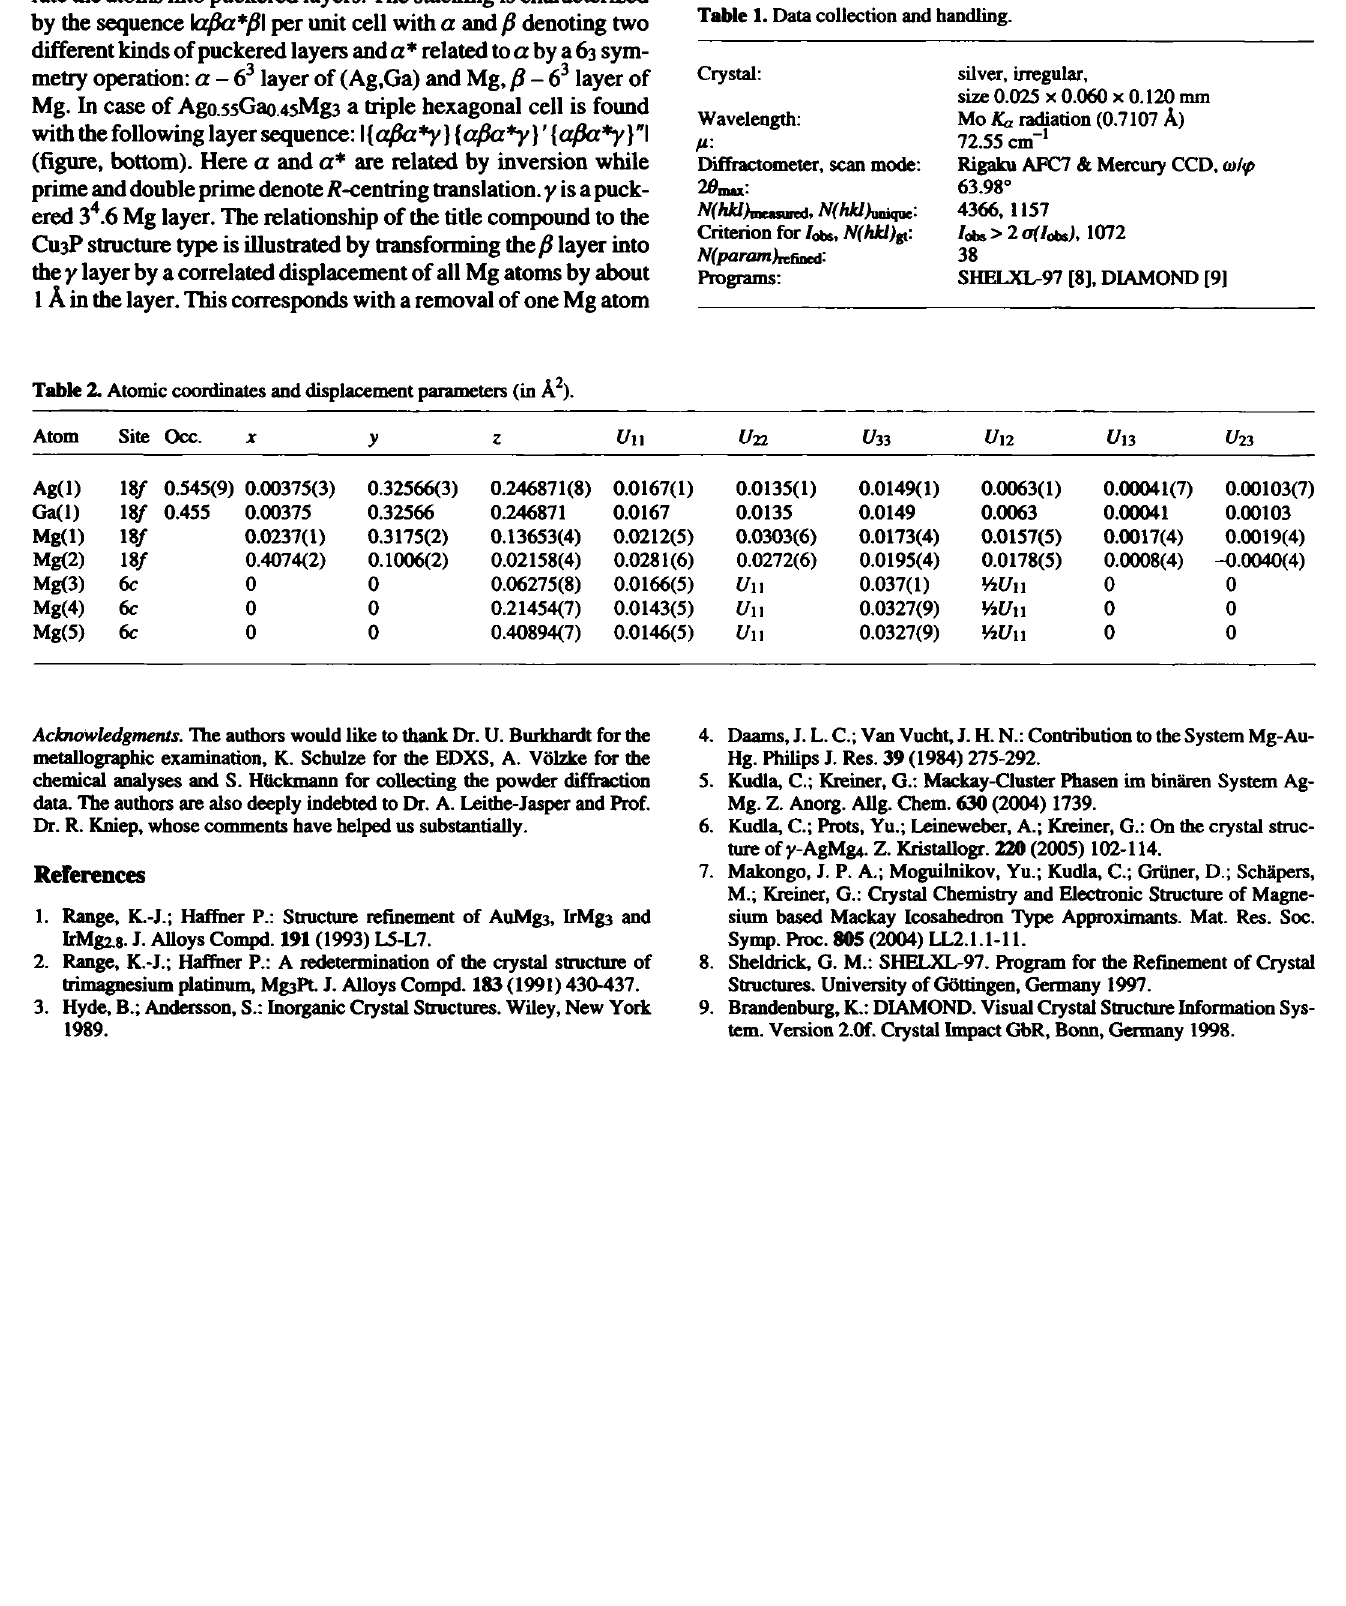
Table 1. Data collection and handling.